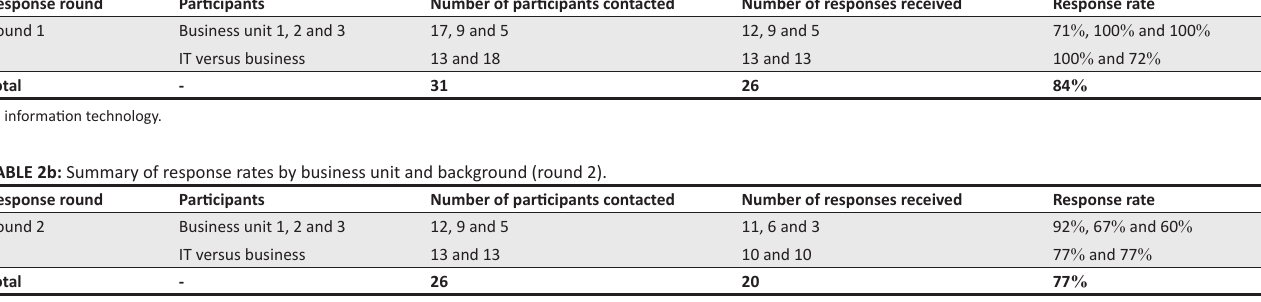
TABLE 2a: Summary of response rates by business unit and background (round 1). Response round